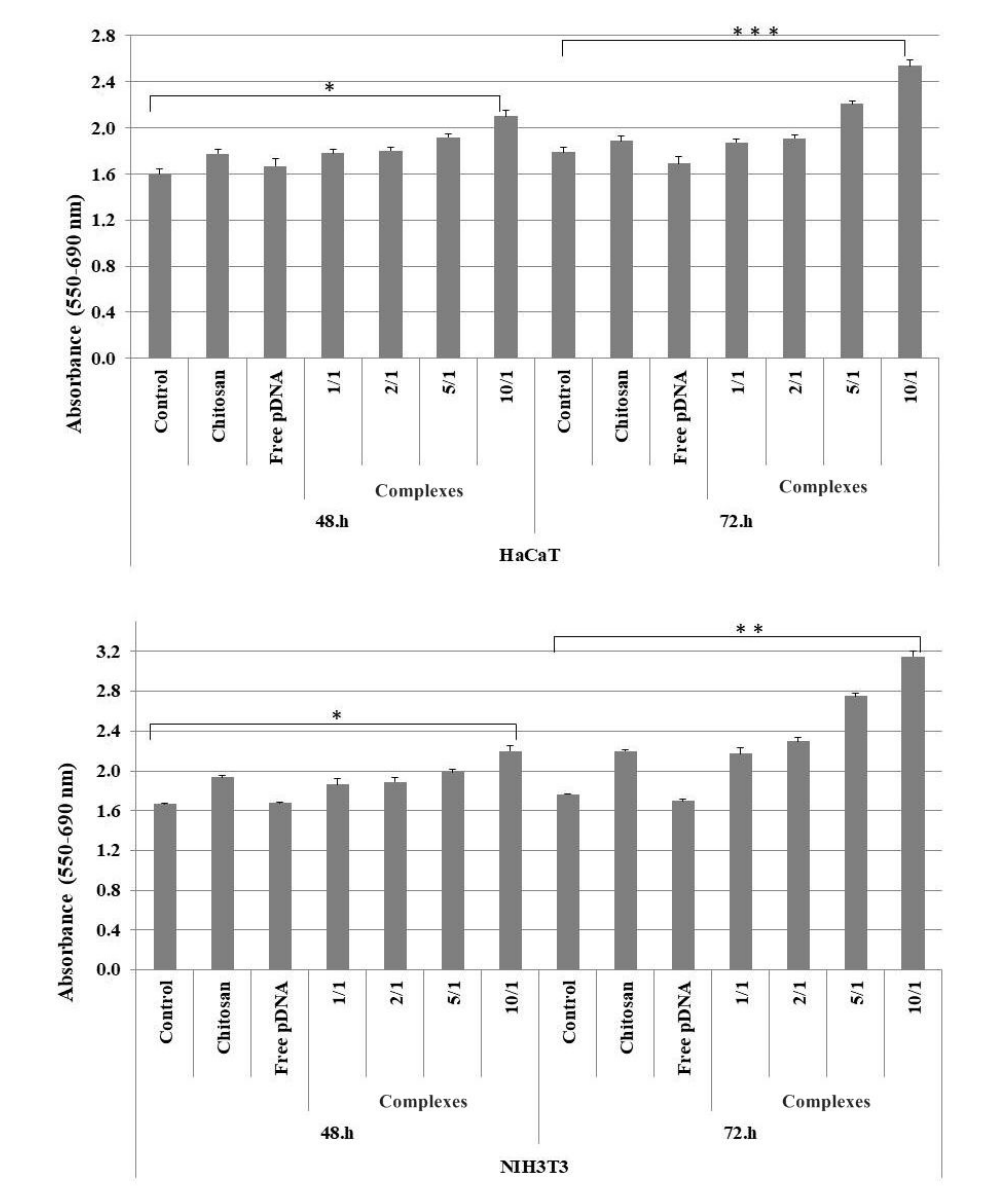
FIGURE 3 - MTT analysis of effect to cell proliferation of chitosan/pGM-CSF complexes in HaCaT and NIH3T3 cells at 48. and 72.